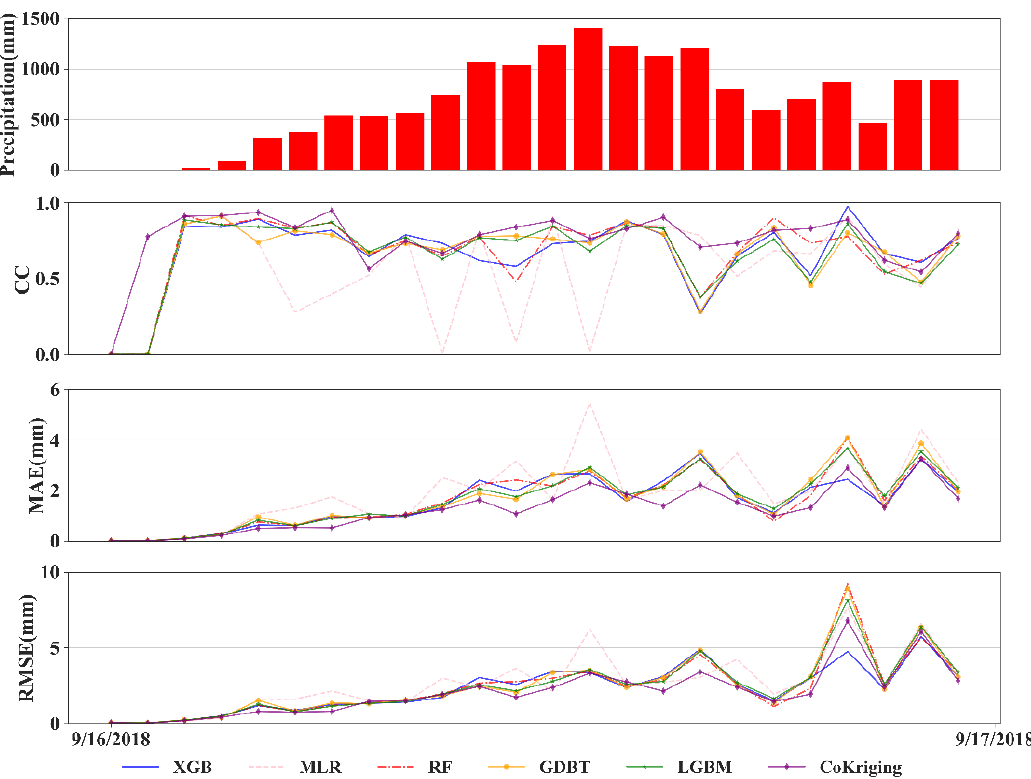
Figure 11. Evaluation indices of heavy rainfall event IV.